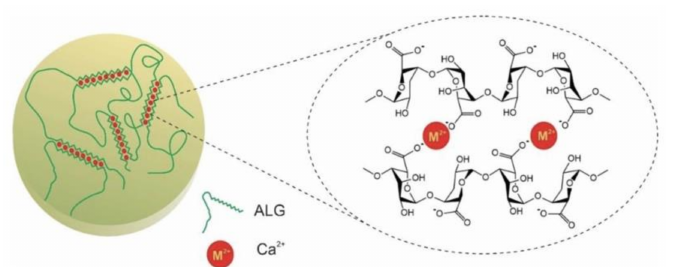
Figure 3. Schematic diagram of sodium alginate cross-linking by Ca 2+ . In the alginate containing − COO − group, Ca 2+ exchanges with Na + from guluronate block in ALG and interacts with separated ALG chains, forming the “egg-box structure”. Reproduced from [41] with permission. Copyright (2020) Springer